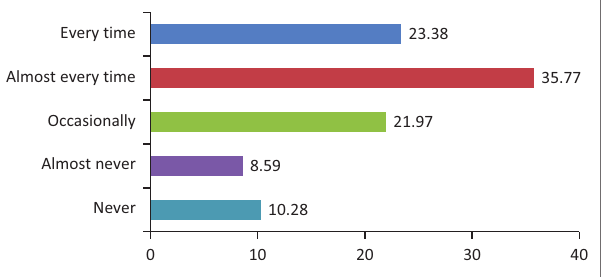
FIGURE 8: Compliance with procedural requirements of